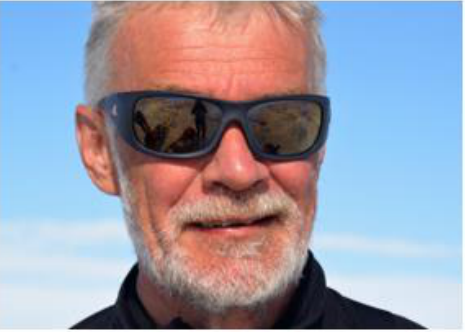
Figure 1. Project initiator Wilfried Korth (1959–2019) on his last Greenland Expedition in